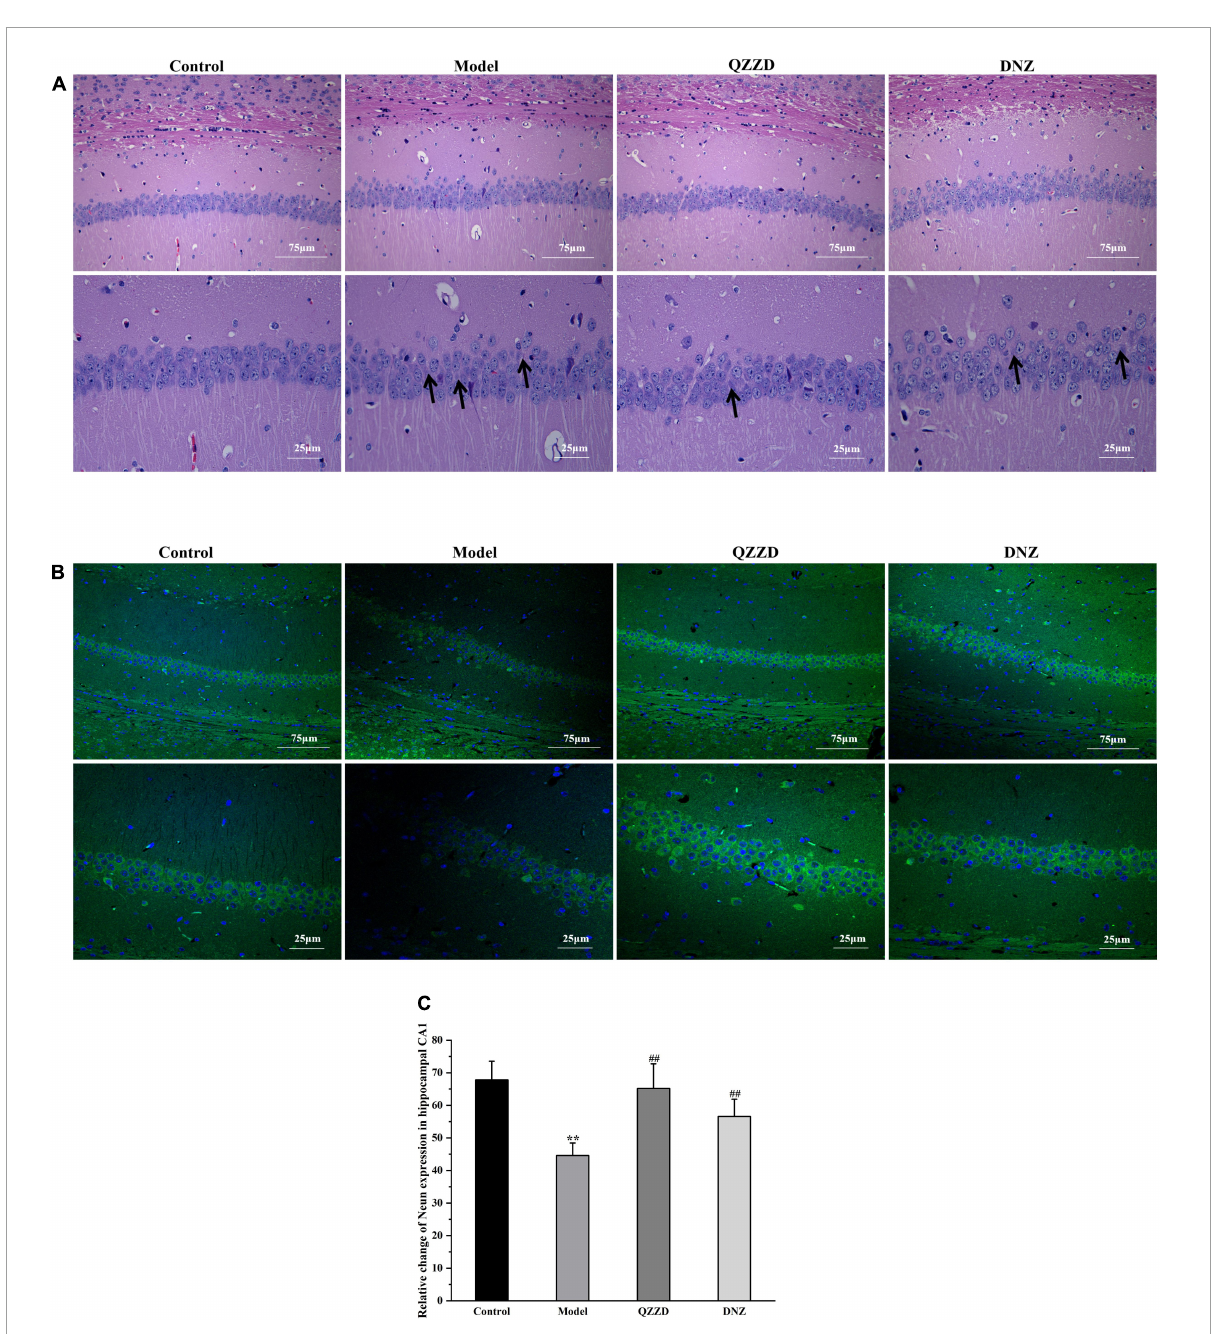
FIGURE10 Effects of QZZD on neuronal death. (A) CA1 region of the hippocampus after HE staining [Scale bar: 75 and 25 µ m (insert), n = 6]. (B) CA1 region of the hippocampus after NeuN staining [Scale bar: 75 and 25 µ m (insert)]. (C) Number of NeuN-positive cells in CA1 region of the hippocampus. Values were expressed as means ± SD, n = 6 in each group. ** p < 0.01, compared with the control group; ## p < 0.01, compared with the model